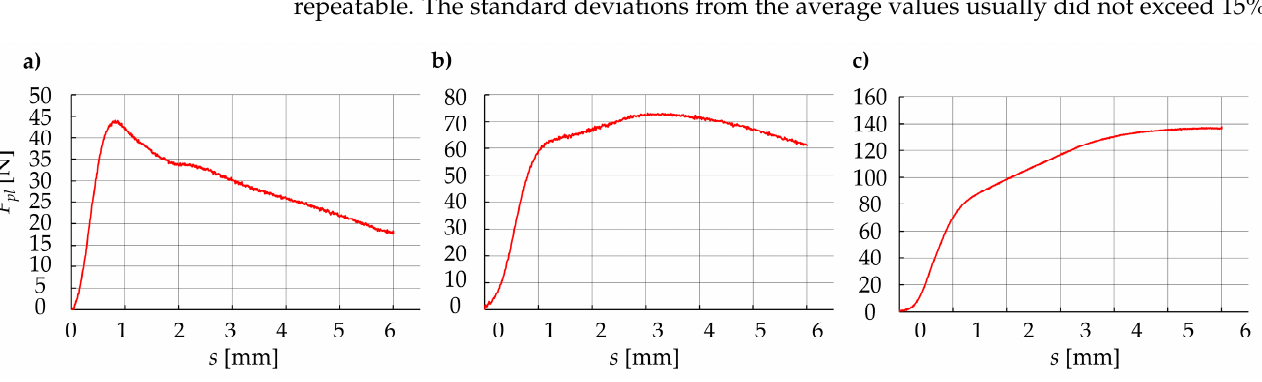
Figure 14. Exemplary results of the plasticization tests for the belt with diameter d = 12 mm, using the hot plate heated to T p = 285 °C: ( a ) plasticization velocity v pl = 6 mm/min, ( b ) plasticization velocity v pl = 8 mm/min, ( c ) plasticization velocity v pl = 10 mm/min.